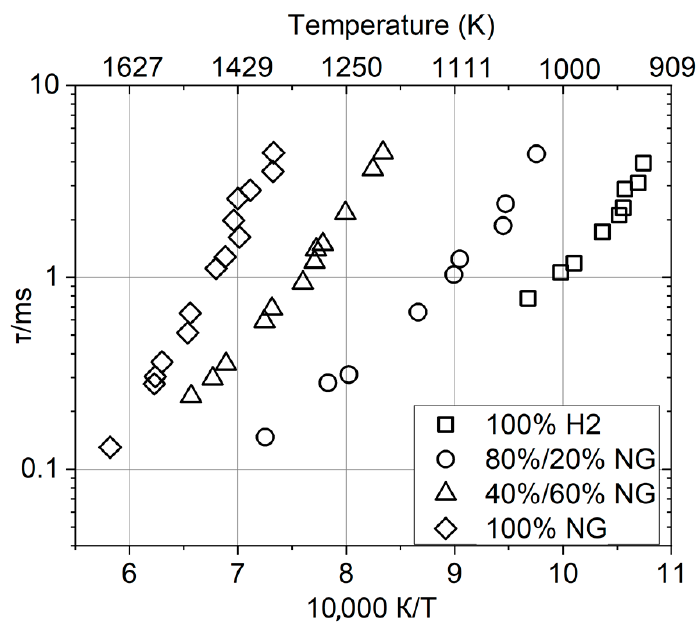
Figure 5. Change in the ignition delay time of a natural gas mixture depending on the volume fraction of hydrogen [13].